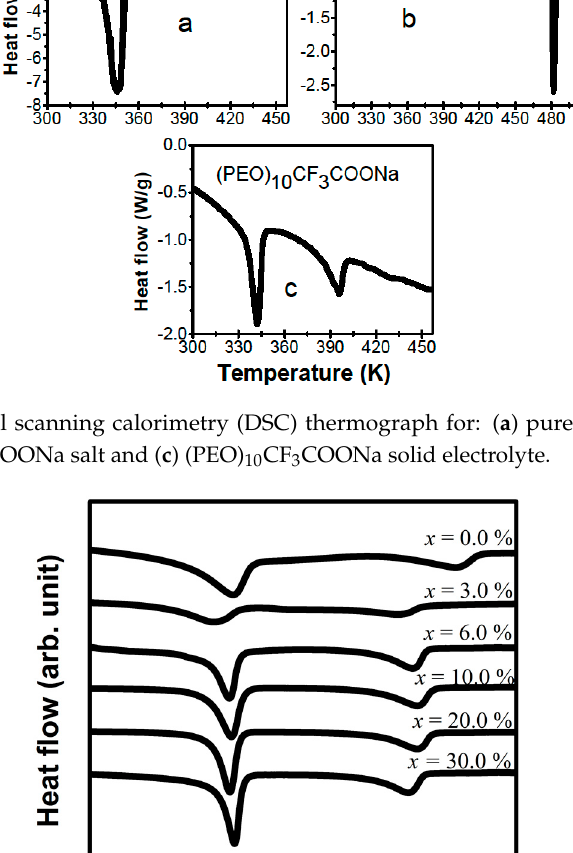
Figure 1. Differential scanning calorimetry (DSC) thermograph for: ( a ) pure poly(ethylene oxide) (PEO); ( b ) pure CF 3 COONa salt and ( c ) (PEO) 10 CF 3 COONa solid electrolyte.